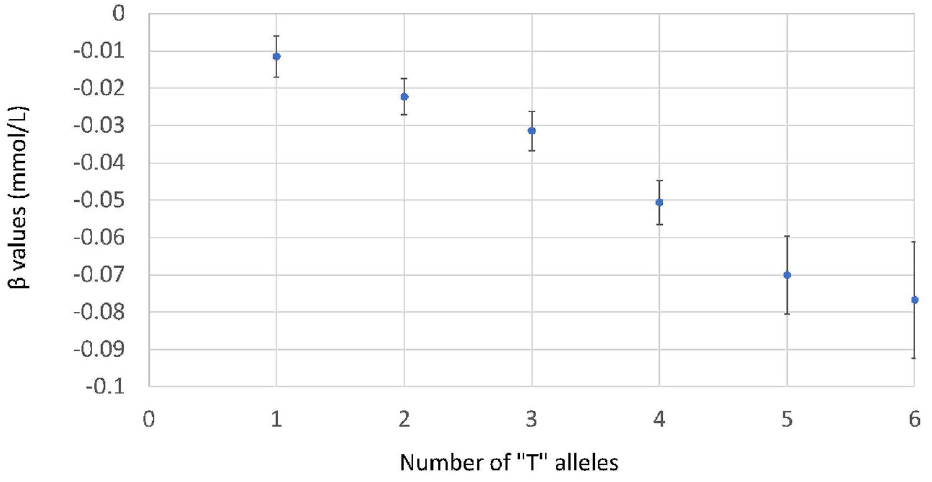
Fig 4. Joint effect size and standard error for fasting glucose at rs1260326 ( GCKR ), rs560887 ( G6PC2 ), and rs13266634 ( SLC30A8 ). The reference group is homozygous for the reference allele at all three SNPs. At each SNP, the T allele is the allele associated with lower fasting glucose.